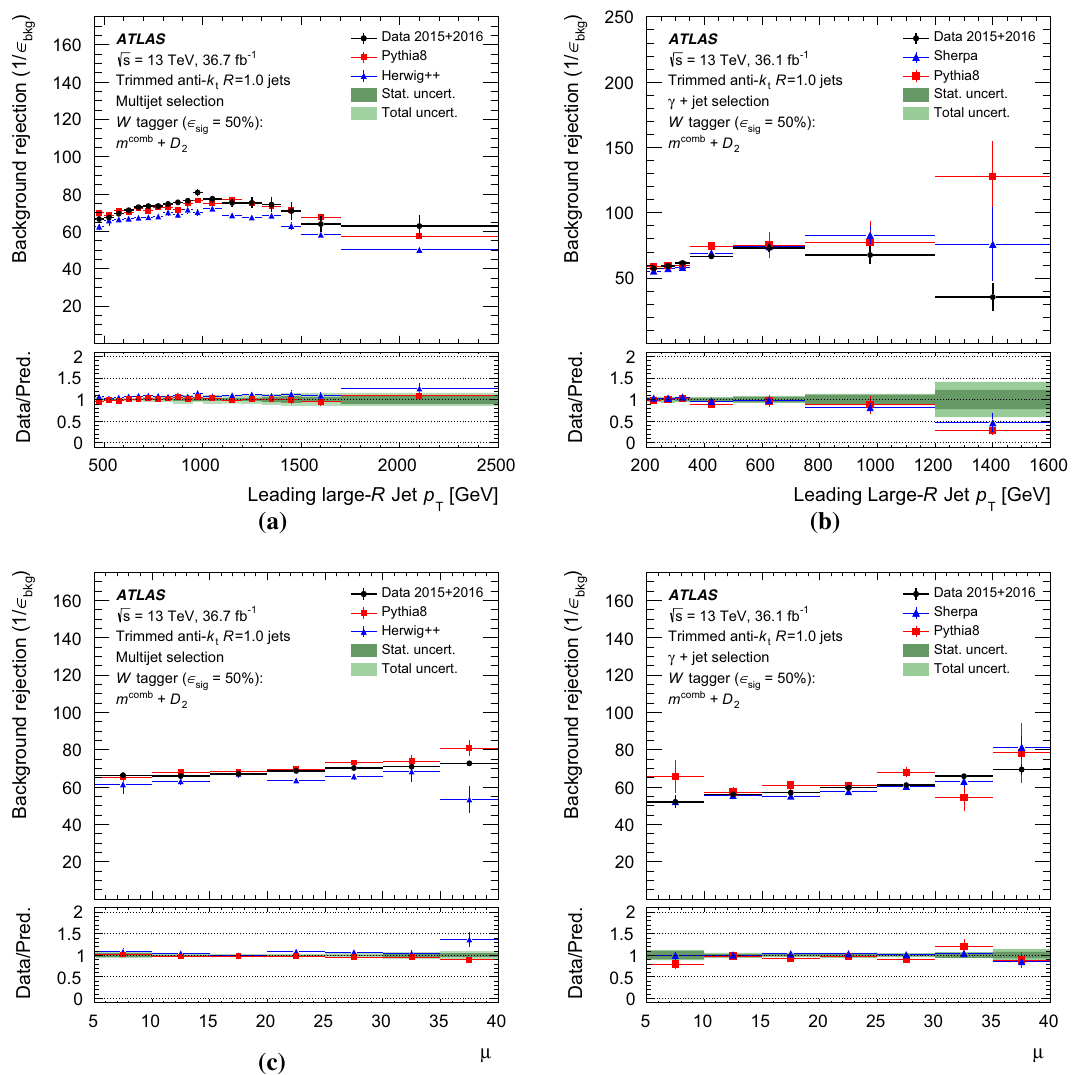
Fig. 33 The estimated light-jet rejection 1 /(cid:12) bkg as a function of the leading jet p T and the average number of interactions per bunch crossing μ for the two-variable W -boson tagger in the multijet ( a , c ) and γ + jet ( b , d ) selection